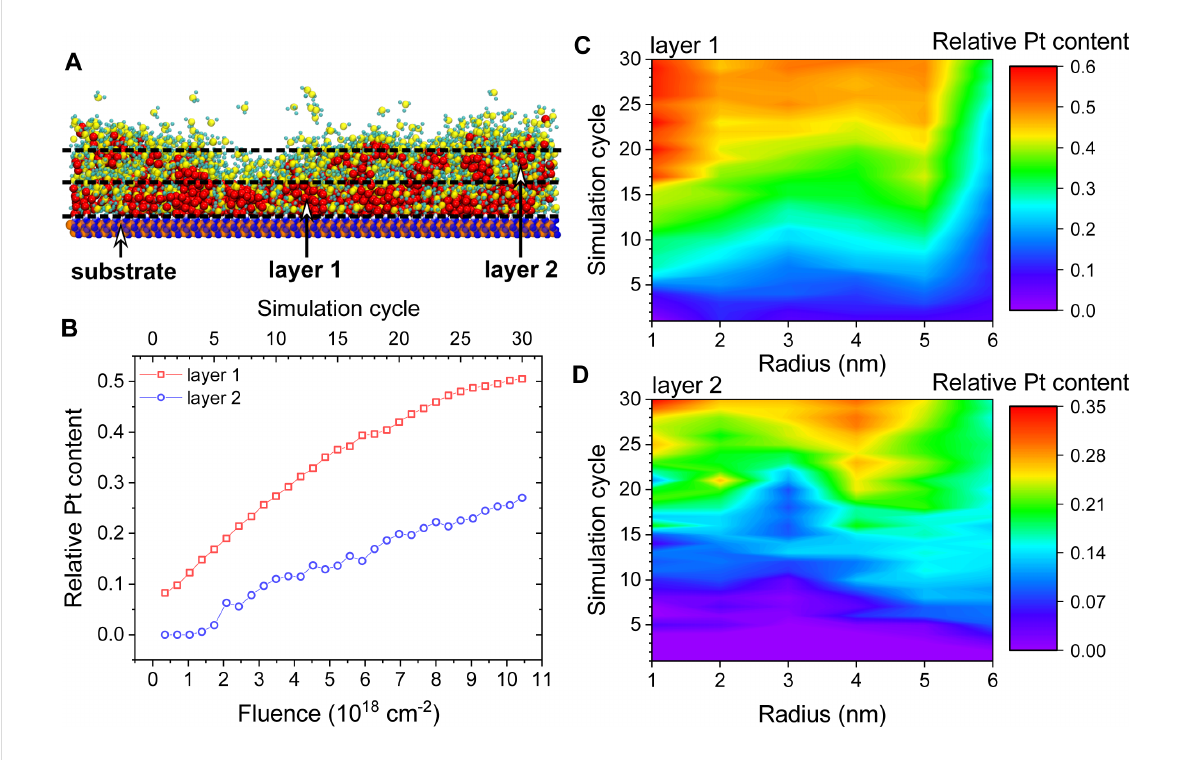
Figure 11: (A) The atomic content of the deposited nanostructure is analyzed by splitting the nanostructure into layers of 0.7 nm thickness each, cor- responding to the height of a Pt(PF 3 ) 4 monolayer. (B) Relative Pt content in the beam spot area for the first two layers of 0.7 nm thickness as a func- tion of the electron fluence. Panels (C) and (D) show the evolution of the radial distribution of relative Pt content for the first and second layers, re-